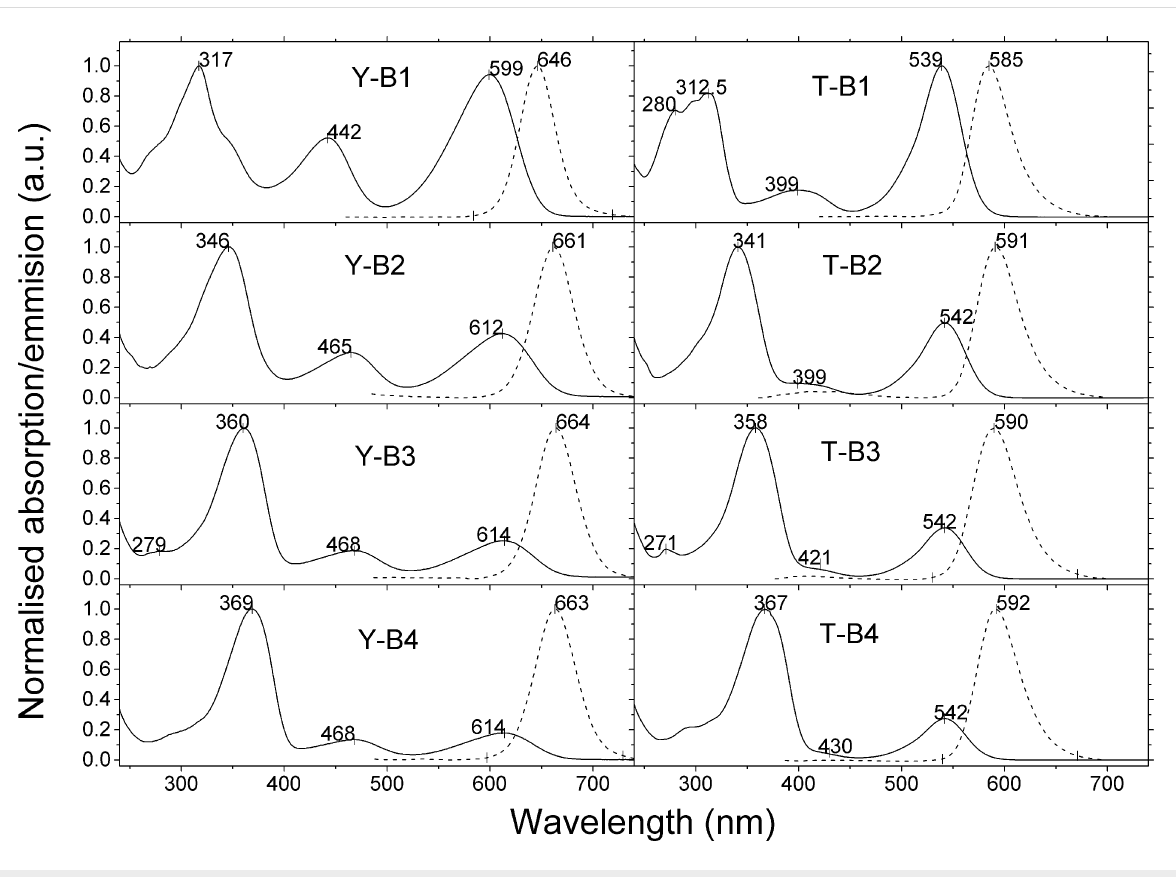
Figure 3: The normalised absorption (solid lines) and emission (dash lines) spectra of Y-Bn ( n = 1–4) (left panel) and T-Bn ( n = 1–4) (right panel) series.